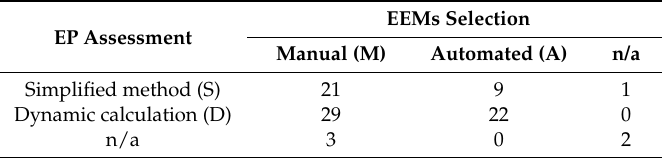
Table 3. Number of papers for each combination of methodological approach.